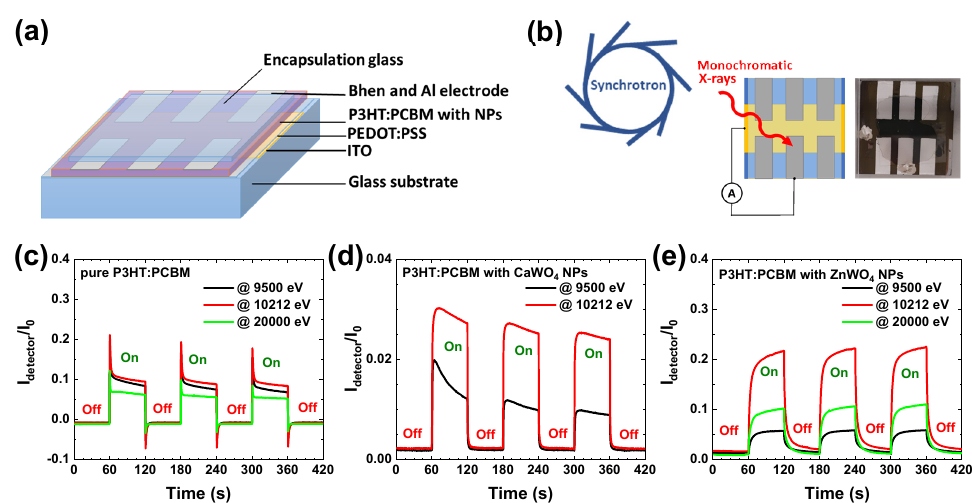
Figure 4. A schematic representation of fabricated hybrid organic–inorganic direct-conversion X-ray detectors ( a ). A scheme of X-ray response measurements at synchrotron, and a photo of fabricated X-ray detector ( b ). X-ray − induced response signals (I detector /I 0 ) for pure P3HT:PCBM ( c ), hybrid CaWO 4 +P3HT:PCBM ( d ), and ZnWO 4 +P3HT:PCBM ( e ) systems under repeated X-ray exposures (on/off